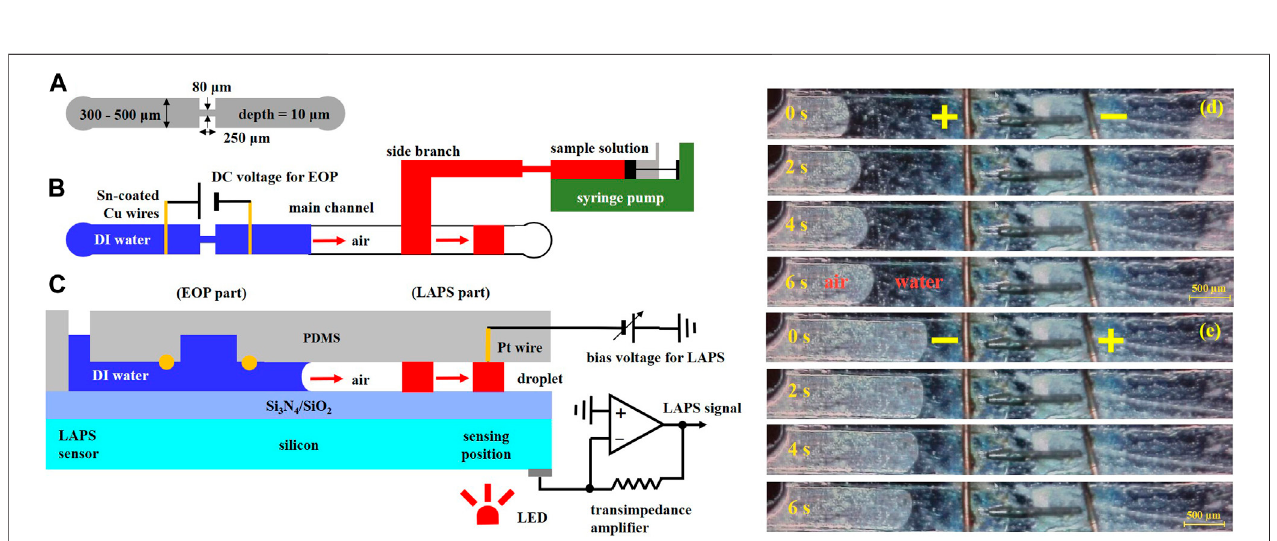
FIGURE 8 | (A) Test structure of the micro fl uidic device combined with a LAPS; (B) Channel design with a chamber for merging and differential measurement; (C) Channel design to generate plugs on the chip; (D) Test structure with two sample chambers, one merging chamber and one sensing area (Miyamoto et al., 2016).